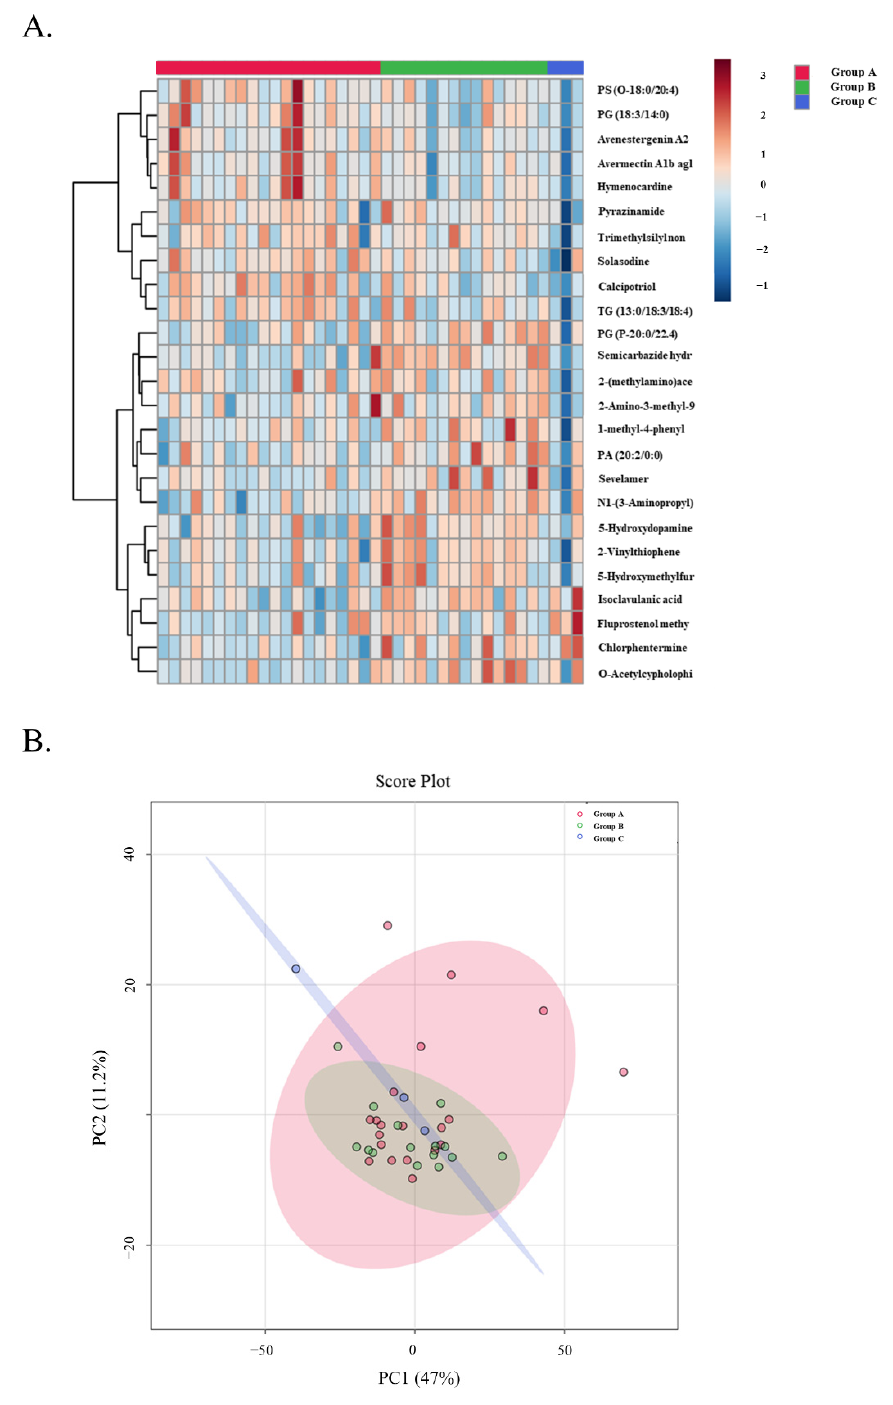
Figure 6. Top 25 metabolites in the three groups. ( A ) LP Heatmap demonstrating the top 25 features in the three groups. ( B ) LP PCA plot demonstrating the top 25 features in the three